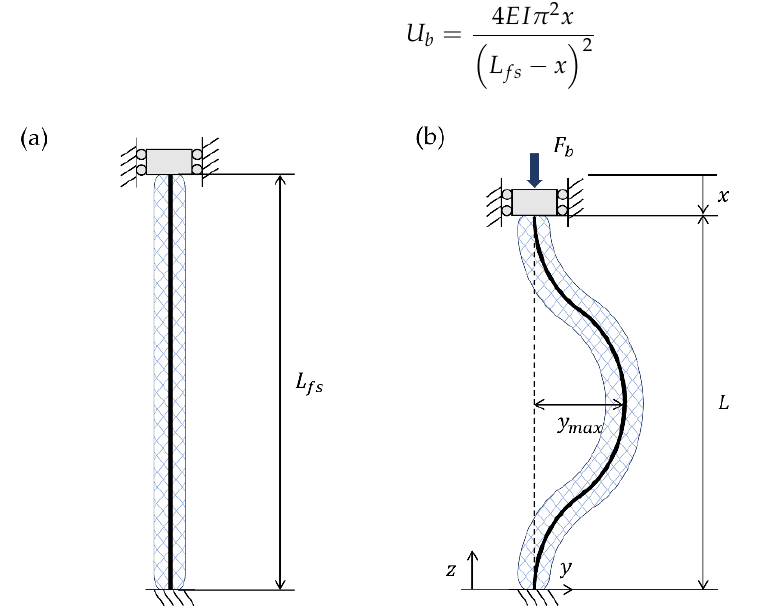
Figure 3. Parameters of McKibben actuator at free strain ( a ) and in post-buckling state ( b